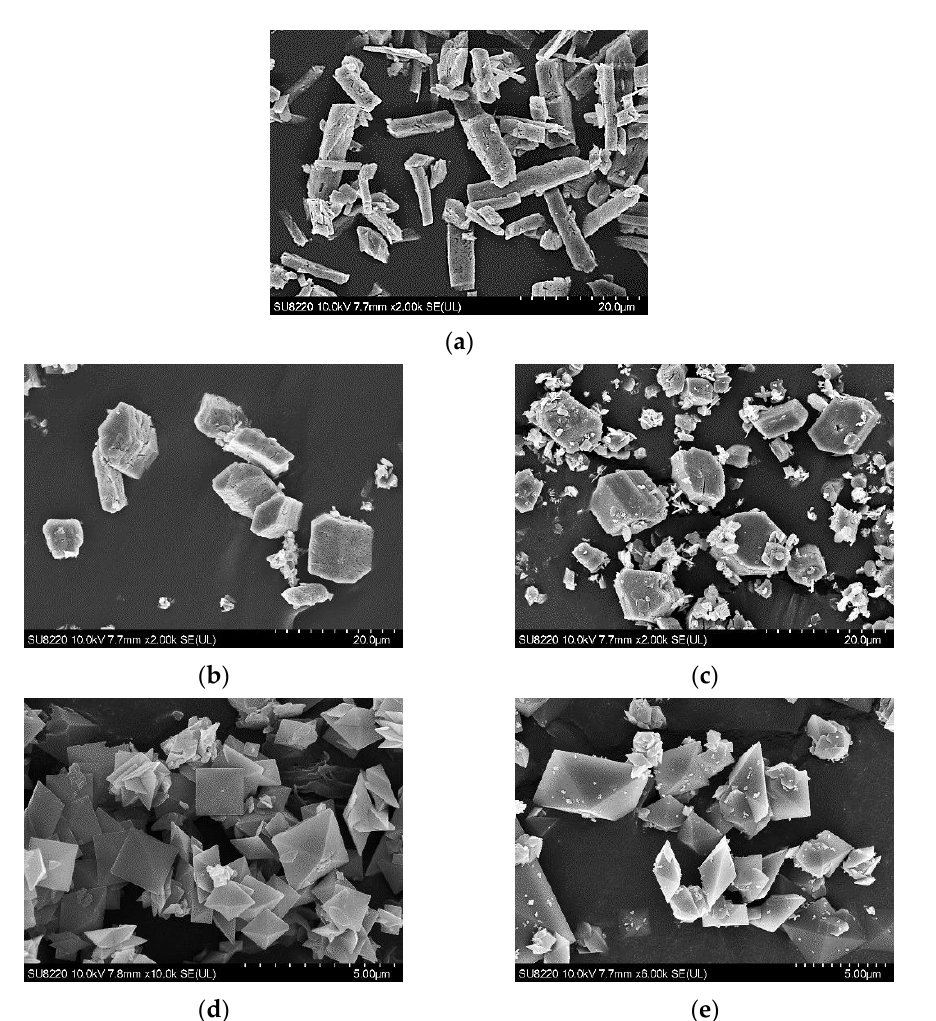
Figure 7. The images of calcium oxalate crystals obtained after 2-h incubation in a crystallizer under various conditions using SEM: ( a ) COM without inhibitors; ( b ) COM in the presence of 400 ppm magnesium ions; ( c ) COM in the presence of 200 ppm citrate ions; ( d ) COD in the presence of 15 ppm chondroitin sulfate ions; ( e ) COD in the presence of 0.5 ppm phytate ions (COM = calcium oxalate monohydrate; COD = calcium oxalate dihydrate; SEM = scanning electron